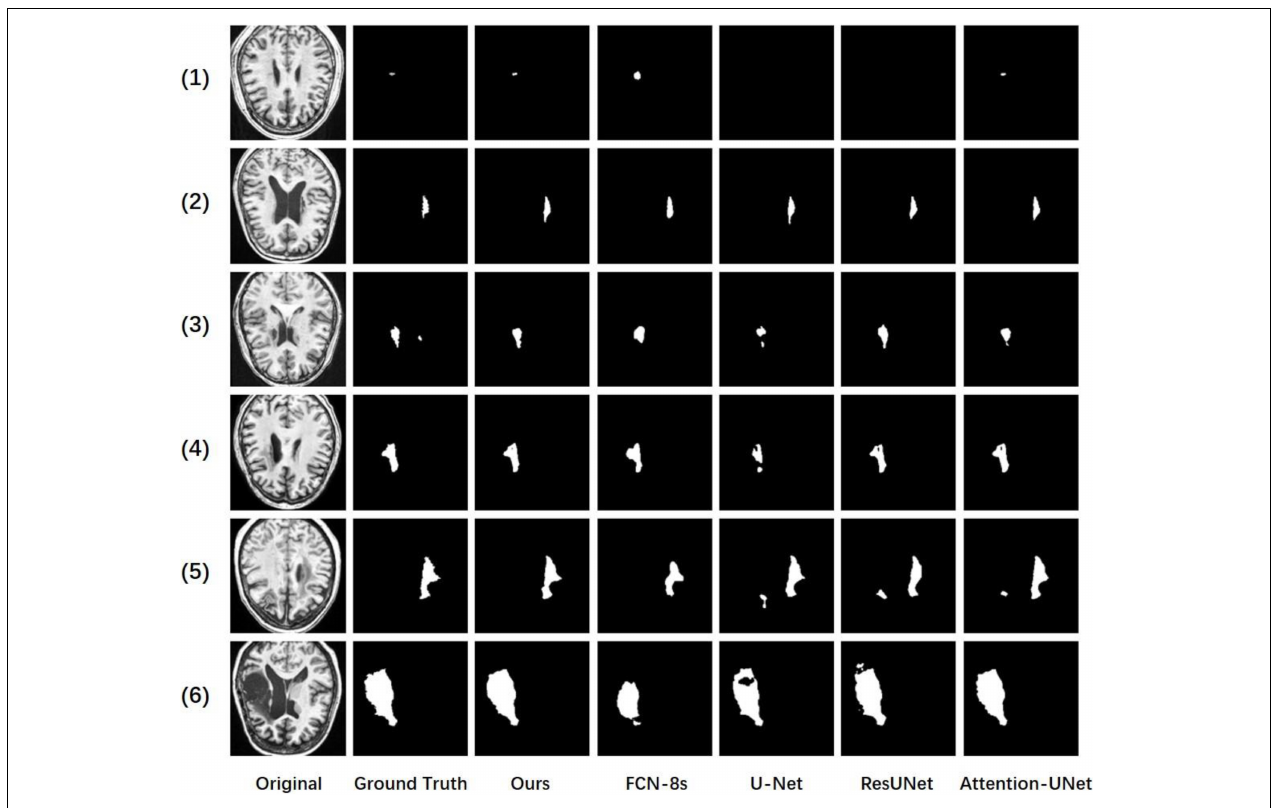
FIGURE 4 | Comparisons of our method, baseline, FCN-8s, U-Net, ResUNet, and attention-UNet.